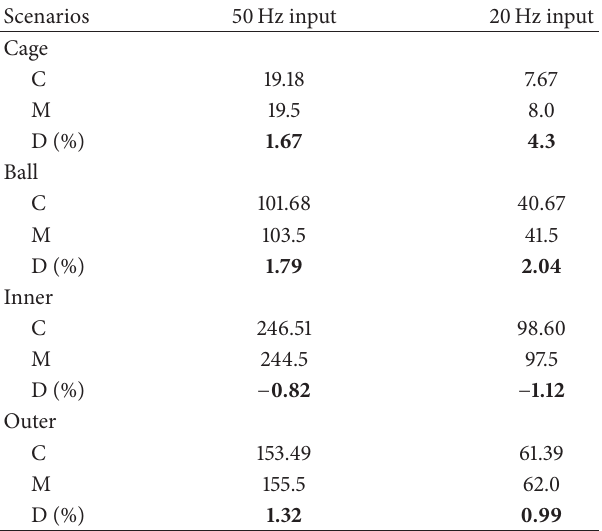
Table 2: Deviations (percentage) of measured and calculated CFs at 20 Hz and 50 Hz motor inputs and free load